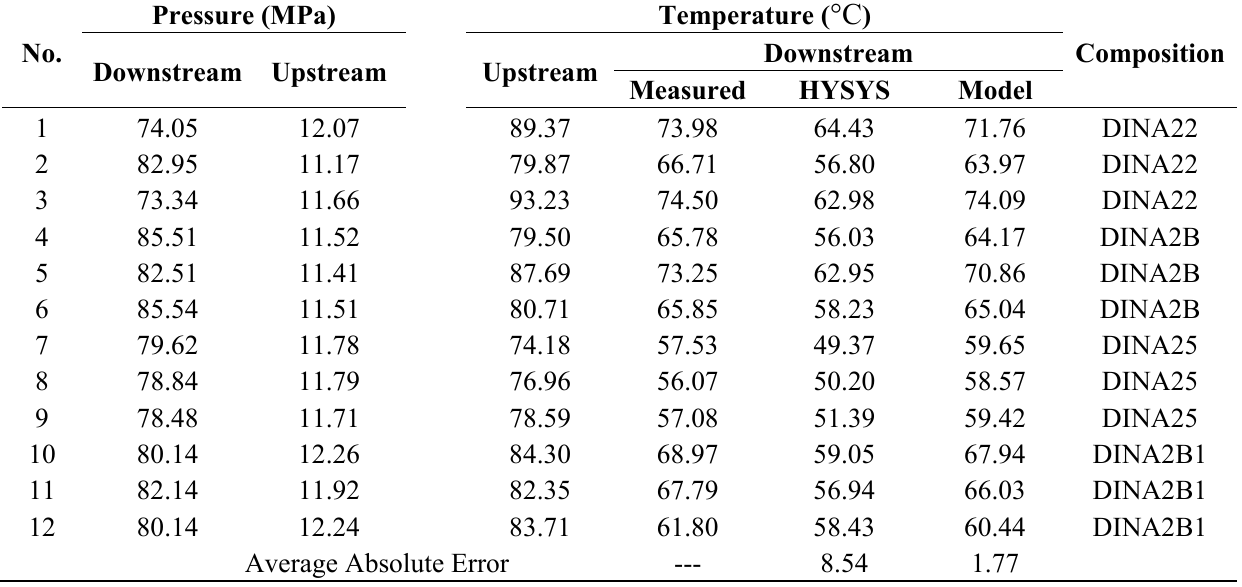
Table 6. Upstream and downstream parameters of 4 condensate